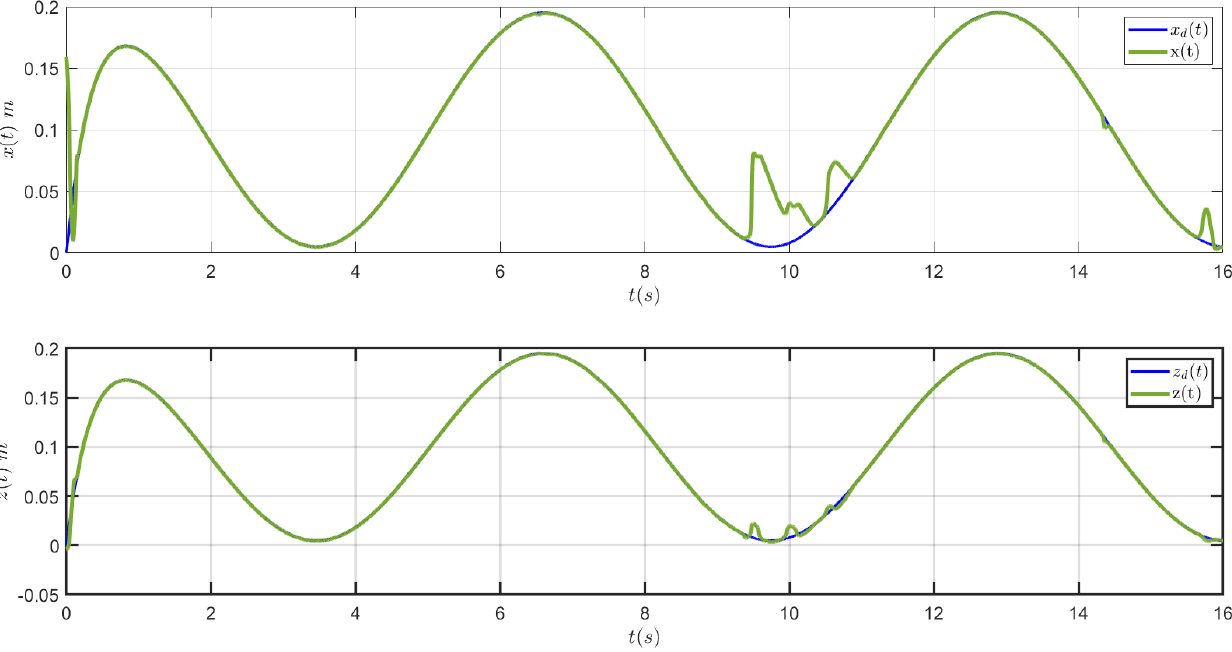
Figure 14. Faulty shoulder abduction